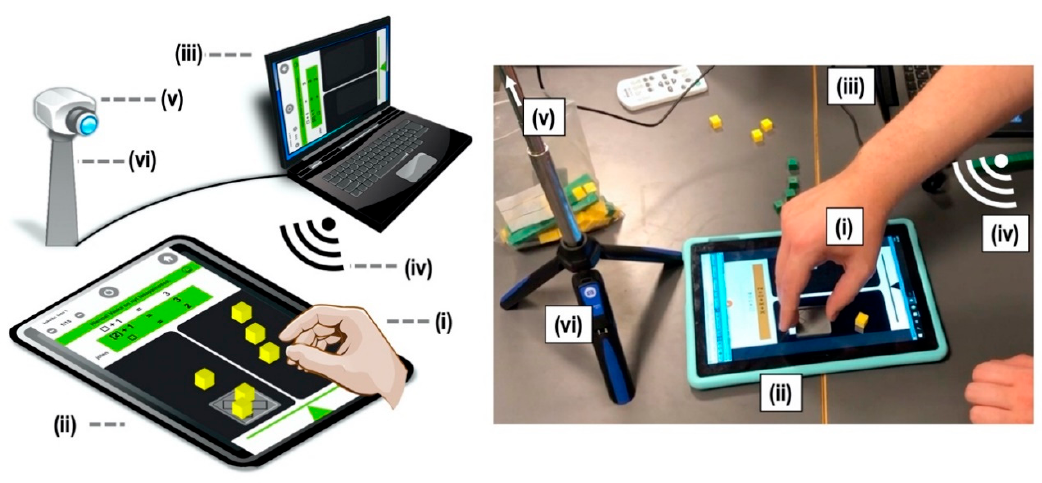
Figure 1. Architecture and components of X-is. ( i ) Placement of physical objects; ( ii ) Tablet screen;